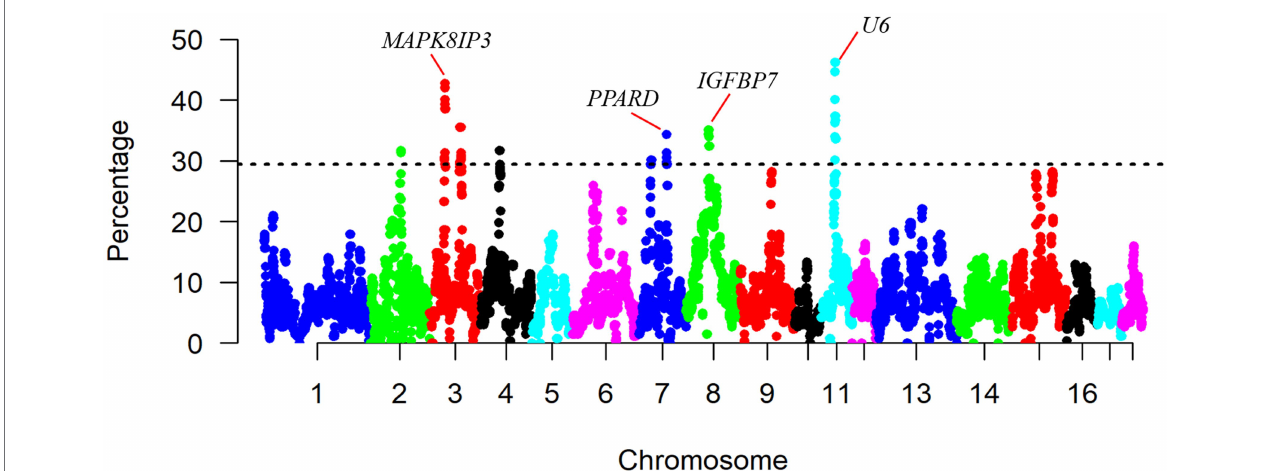
FIGURE 4 | Manhattan plot of occurrences (%) of a SNP in ROHs across individuals.